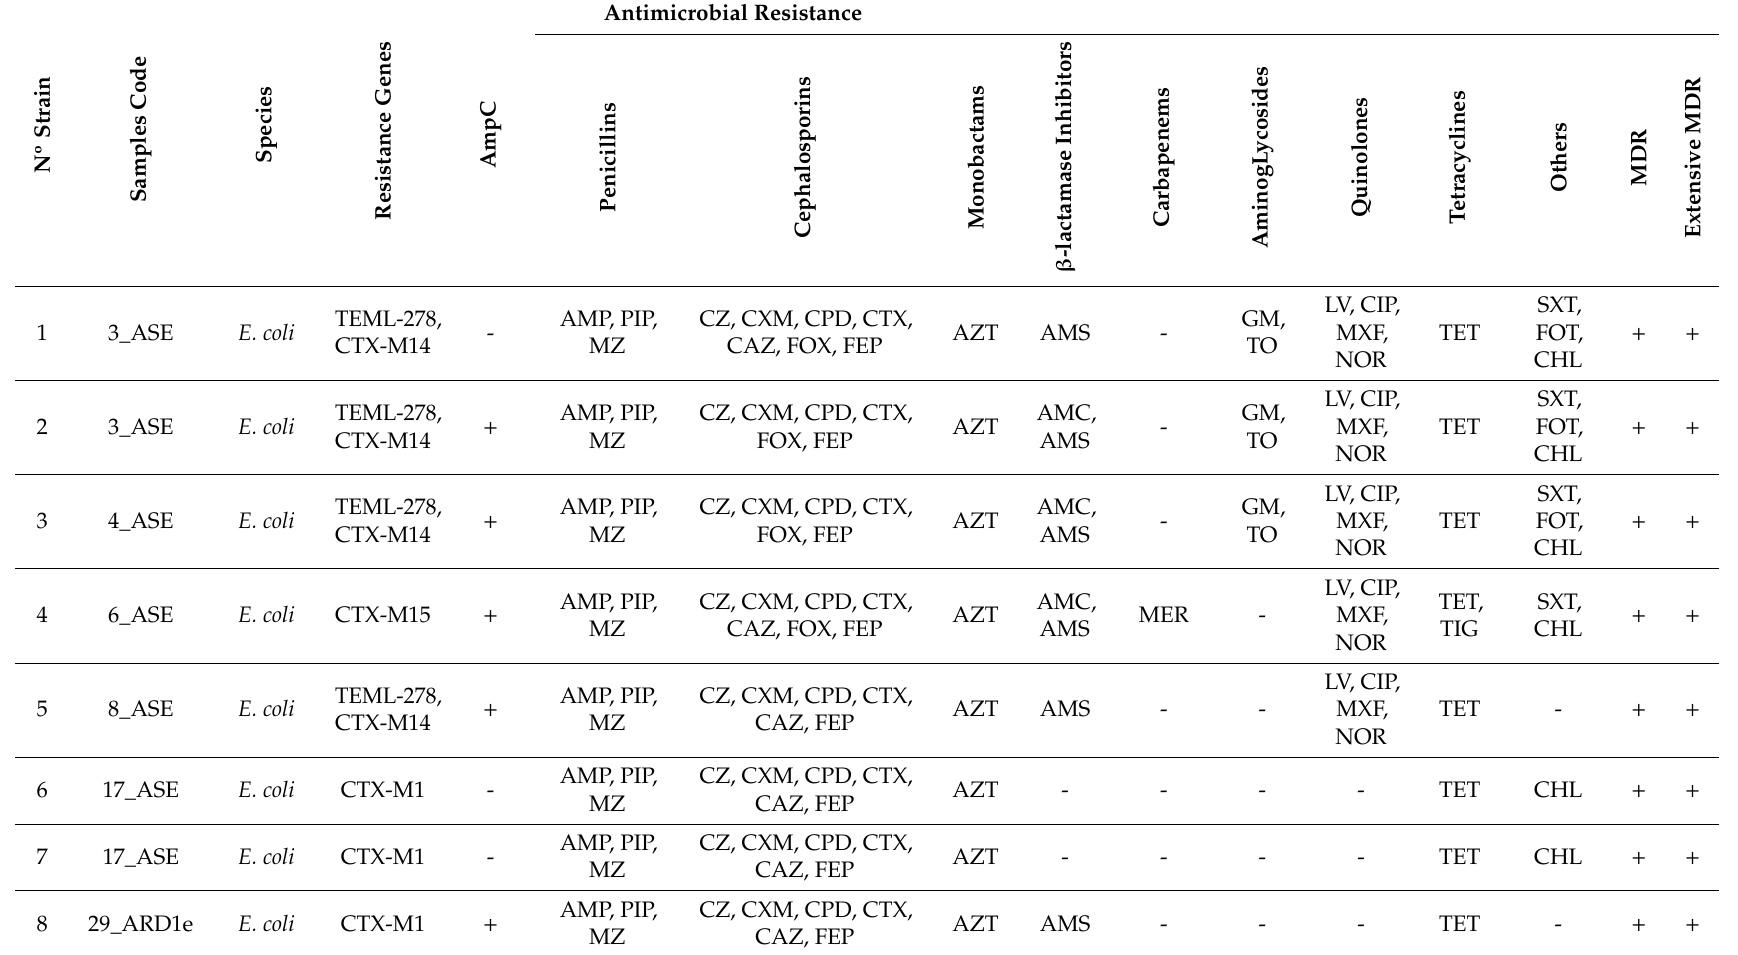
Table 5. Characteristics and antibiotic resistance profile of isolated Gram negative